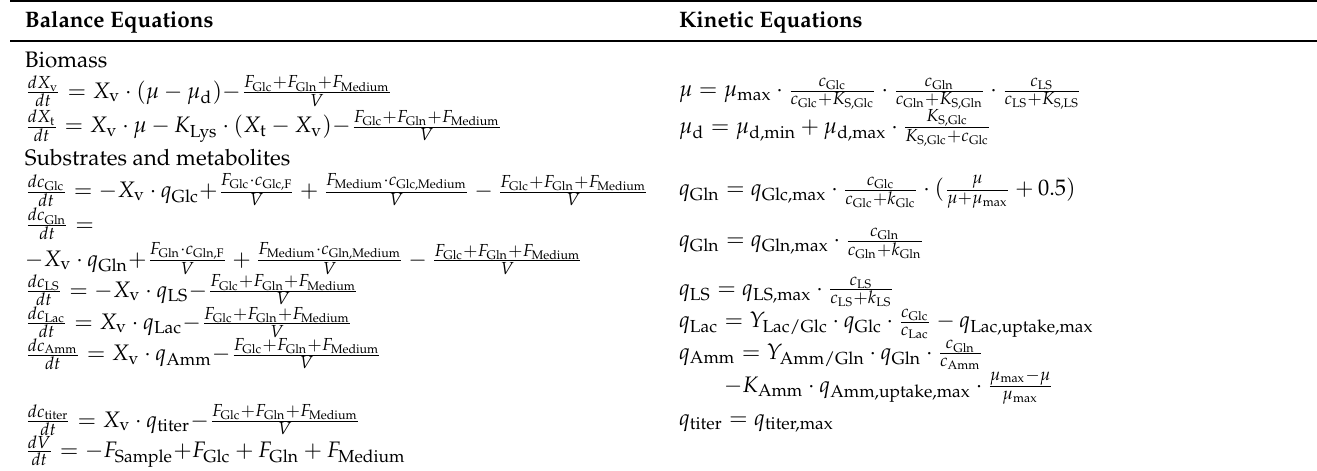
Table 2. Mechanistic model (for batch and fed-batch mode) [12,13,22,23] for descriptions of cell growth, cell death, substrate uptake, metabolite production and antibody production. Balance Equations Kinetic